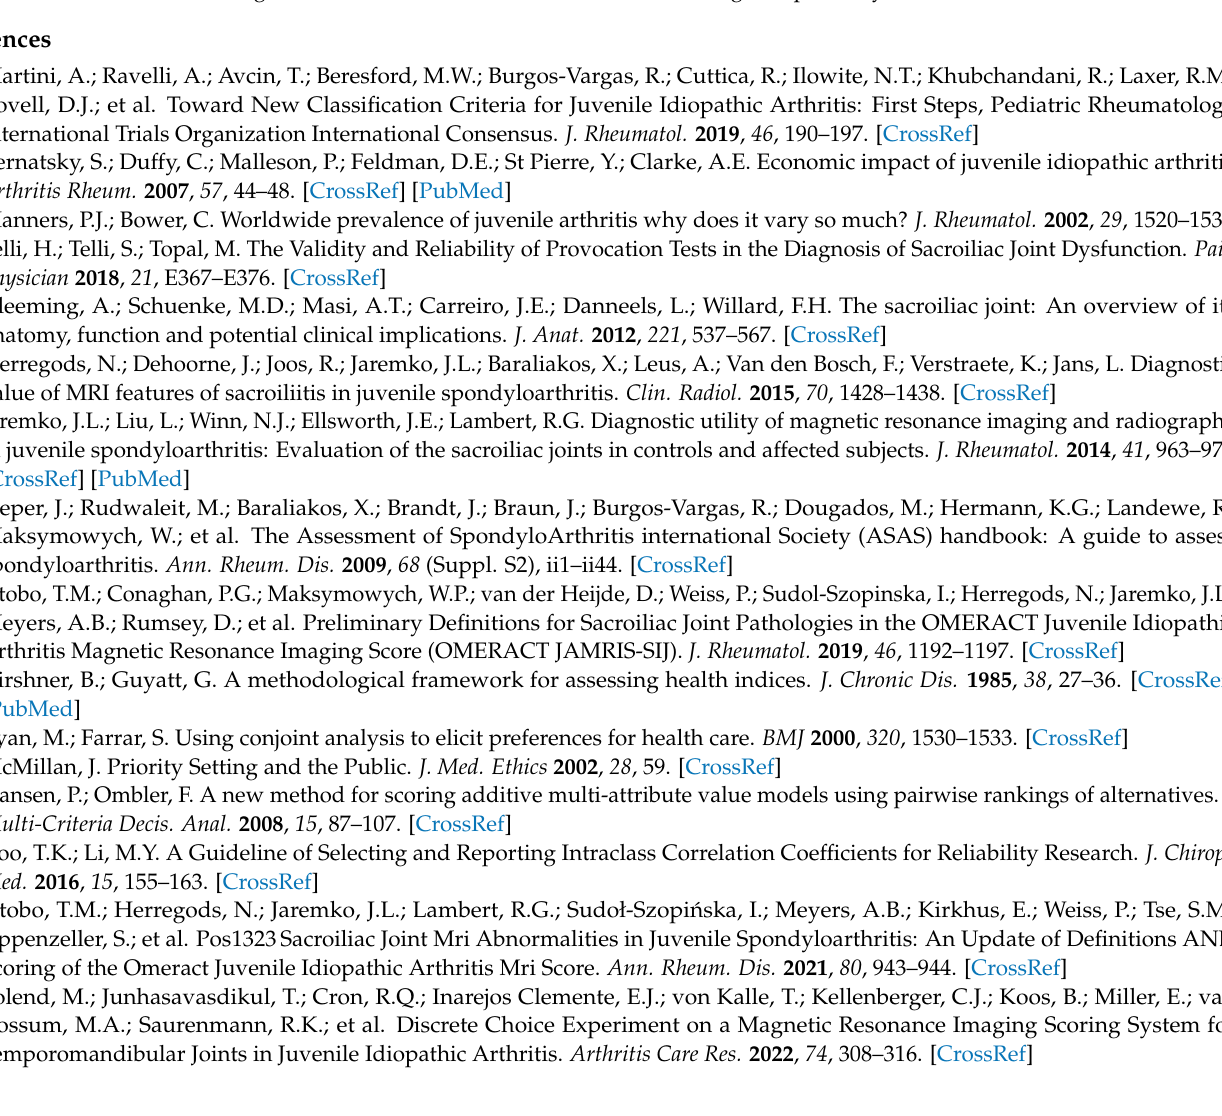
Figure A4. JAMRIS-SIJ grade-only vignette used for ranking exercise to test conjoint analysis survey (CAS)-derived weights. Fourteen grade-only vignettes were constructed corresponding to various combinations of pathologies in the JAMRIS-SIJ. Experts individually ranked the cases from the greatest to least level of inflammation and damage, respectively.